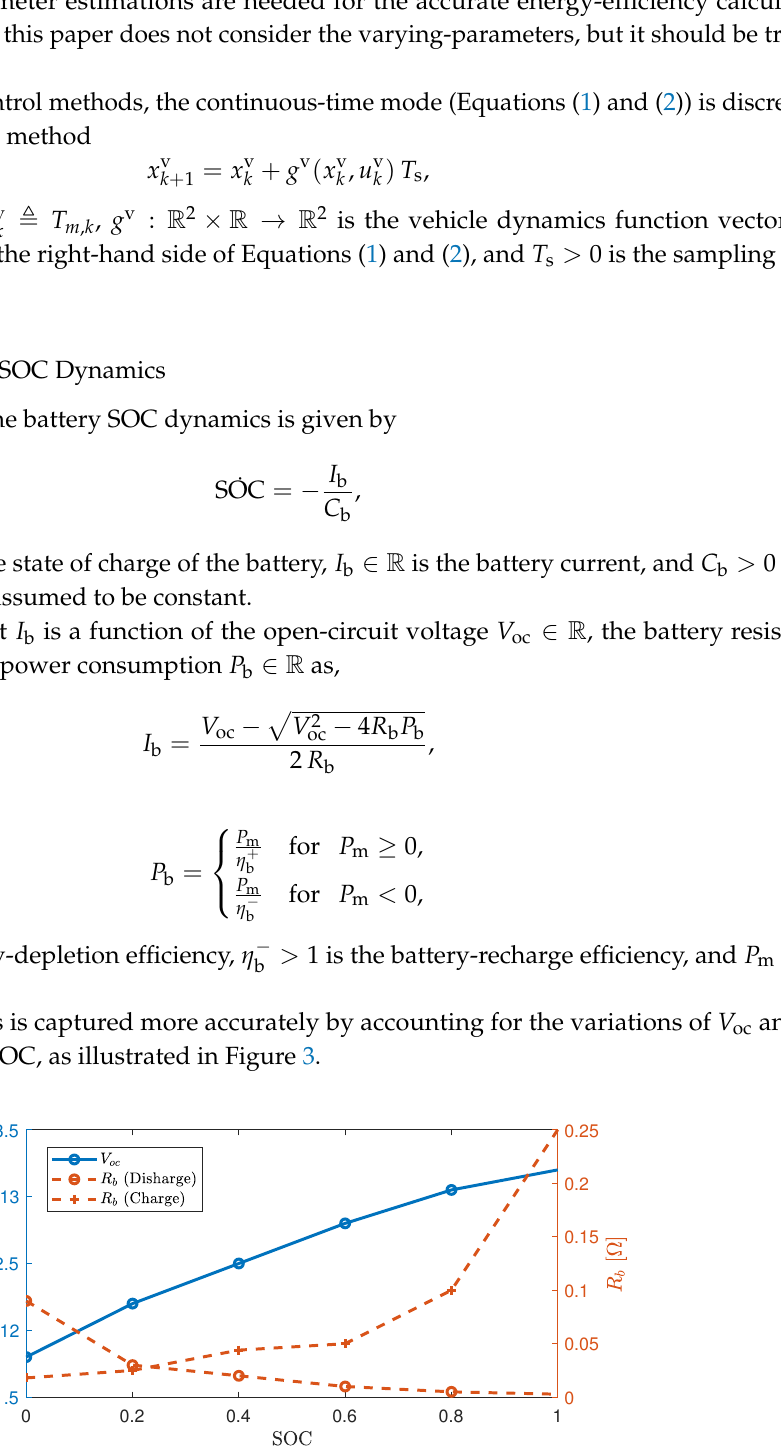
Figure 3. Variation of the open-circuit voltage V oc and internal resistance R b as functions of state-of-charge